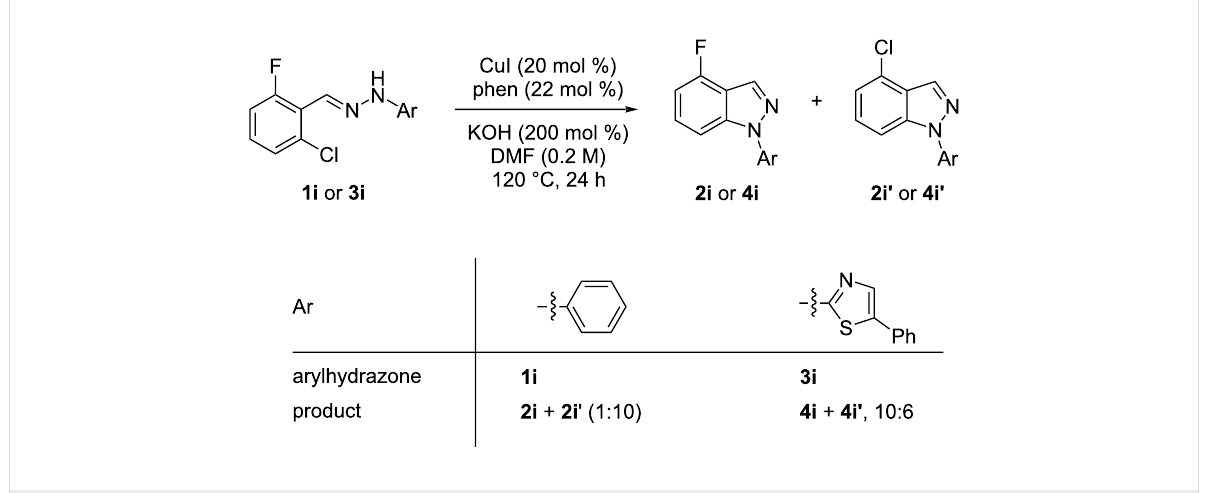
Scheme 2: Regioselectivity of the reaction of arylhydrazones 1i and 3i ,